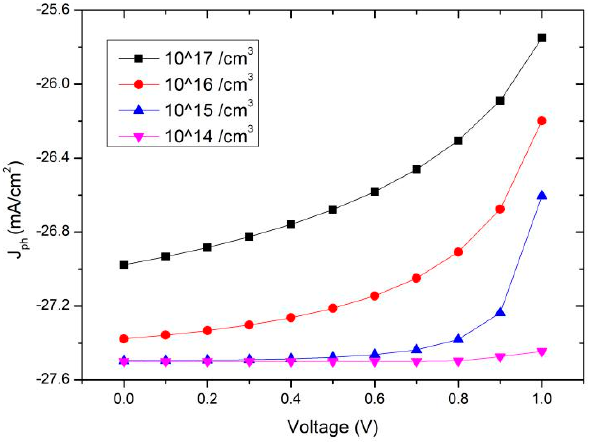
Figure 7. Bias voltage dependence of photocurrent at various doping densities.